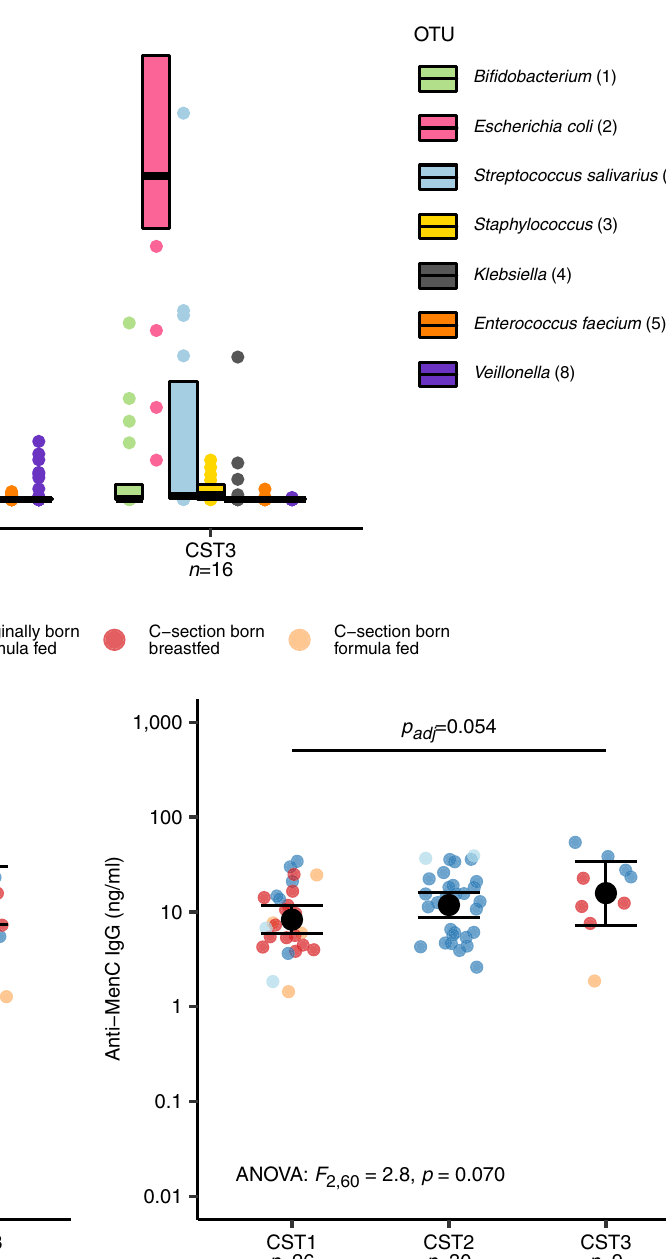
colored according to modeof deliveryandfeeding typefrom birth.Blackdotsand error bars represent GMCs with 95% CI. Signi fi cance was assessed using two-sided ANOVA on log-transformed IgG concentrations followed by post-hoc Tukey – Kramer tests, correcting for time between vaccination and IgG measure- ments. p adj =FDR-adjusted p -value.SourcedataareprovidedintheSourceData fi